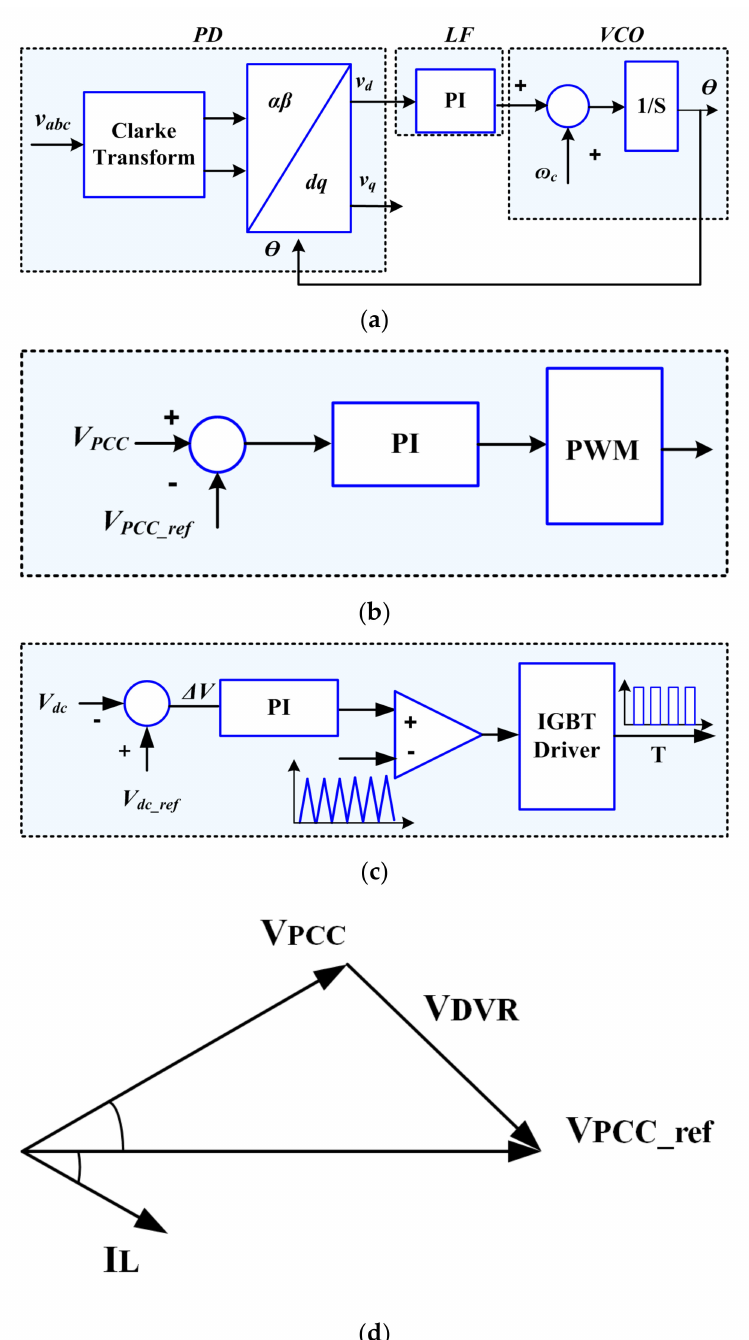
Figure 6. ( a ) PLL diagram, ( b ) Control strategy DVR during fault, ( c ) Control strategy of the boost chopper during fault, ( d ) phasor diagram of DVR voltage